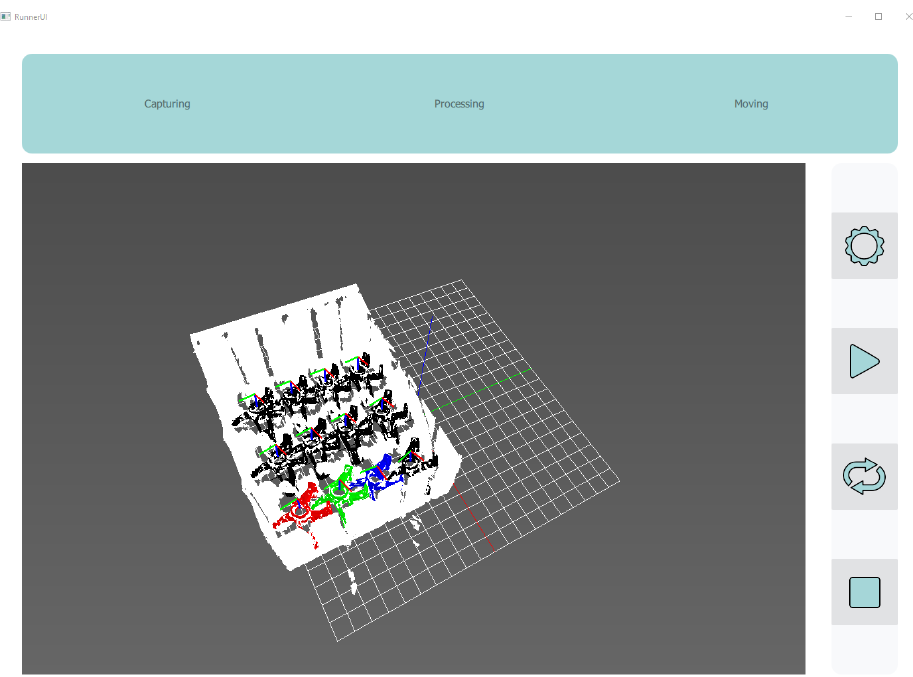
Figure 5. User interface for control and monitor a picking